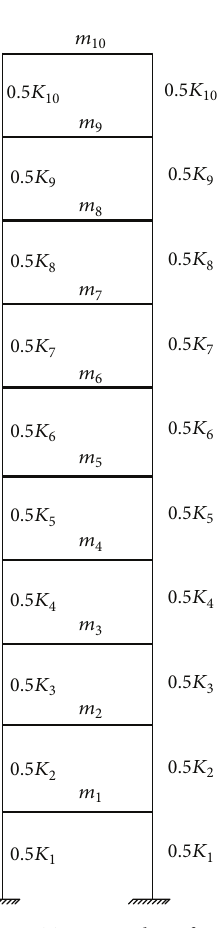
Figure 7: Ten-story shear